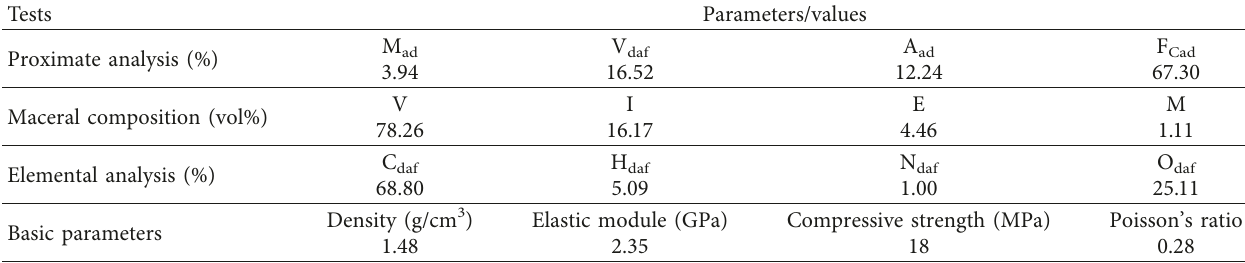
Table 1: Component and basic parameters of coal rocks used in the experiments.